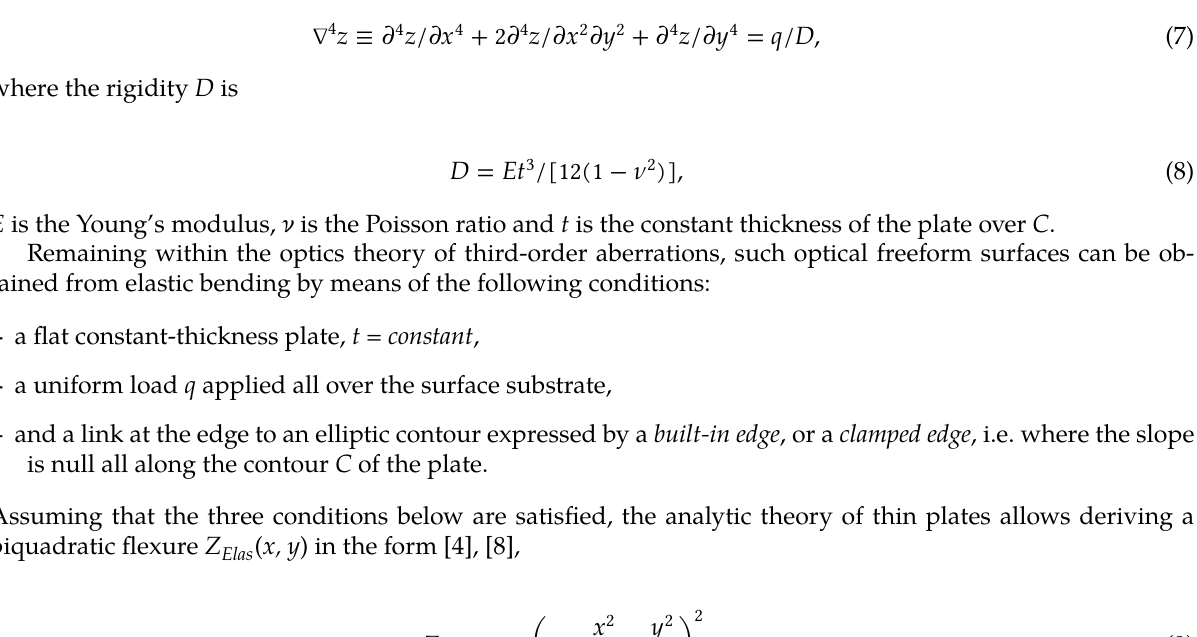
Figure 4: Top view of an elliptical vase form . The clear aperture of M1 mirror is included into a smaller surface to that of a constant thickness plate delimited by elliptical contour C (dotted line) and defined by semi-axe radii ( a is built-in to the plate at contour C where n -directions are normal to C . The outer ring is delimited by a homothetic elliptic contour C ′ defined by semi-axes radii ( b